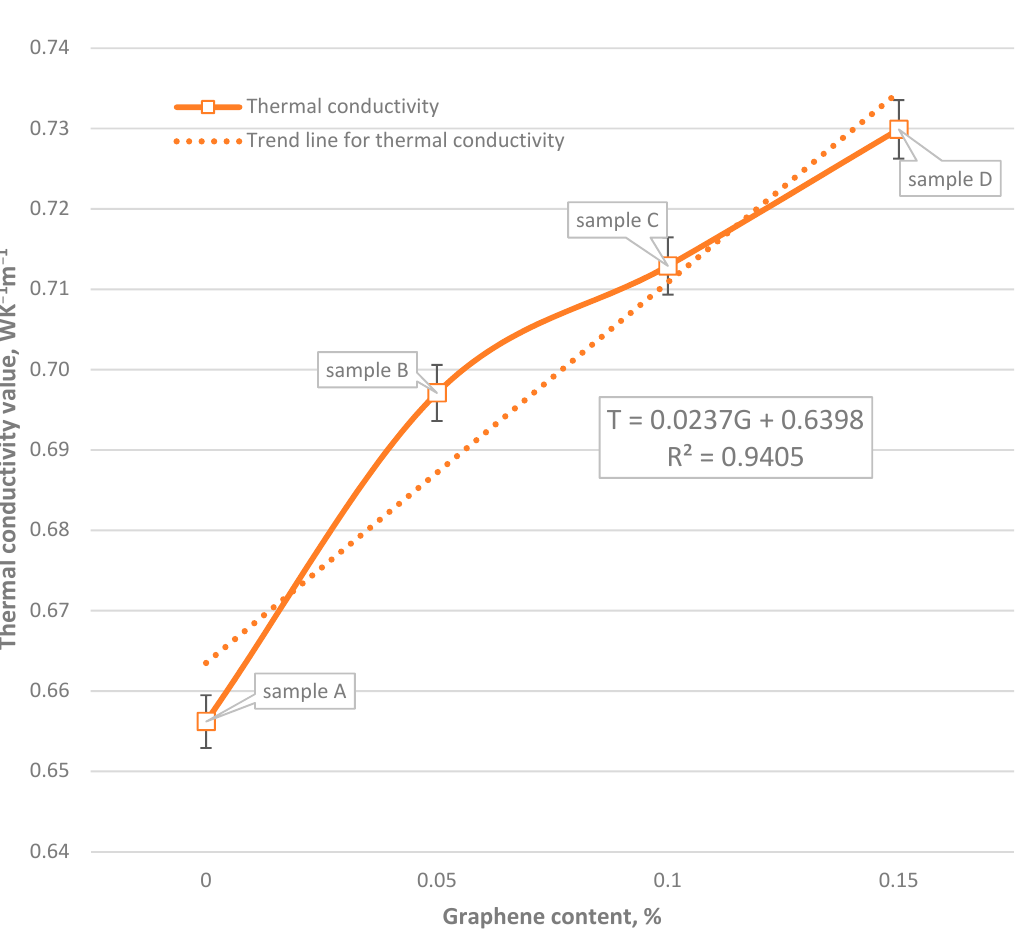
Figure 15. The relationship between the thermal conductivity (T) and the graphene percentage (G).